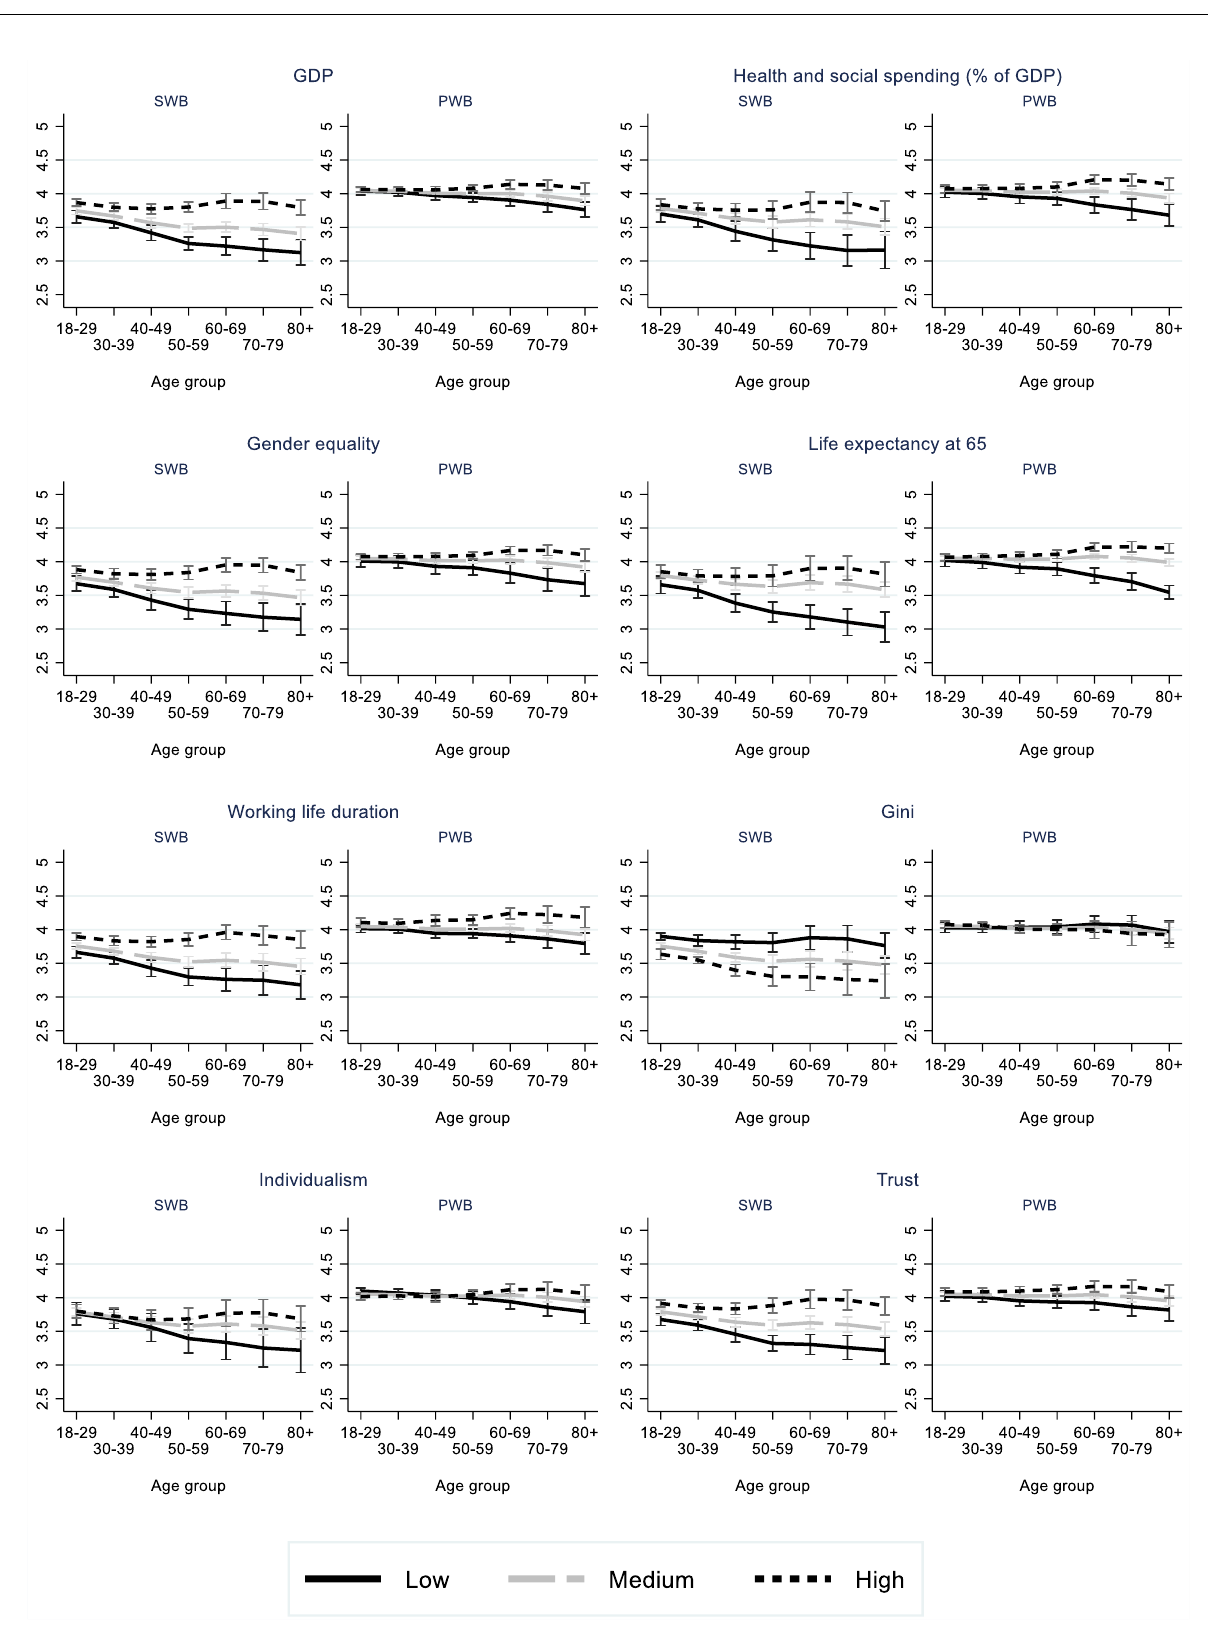
Figure A1. Predicted level of subjective wellbeing ( SWB ) and psychological wellbeing ( PWB ) by age and high (p90), medium (p50) and low (p10) values of individual WS indicators. Results from multi-level regressions. NB Scale in Figure 2.5 – 5.